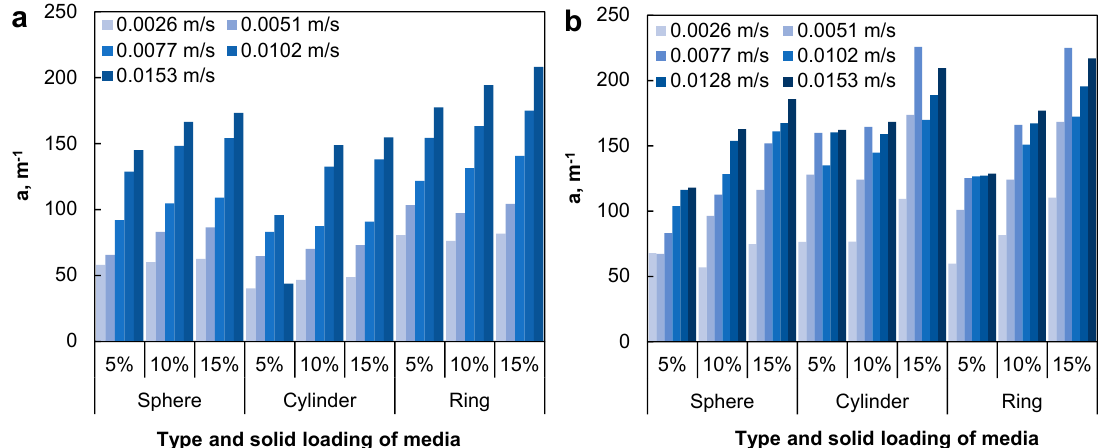
Figure 6. Bubble specific interfacial area (a) with different solid loadings of each media type in: (a) BCR and (b) ALR.